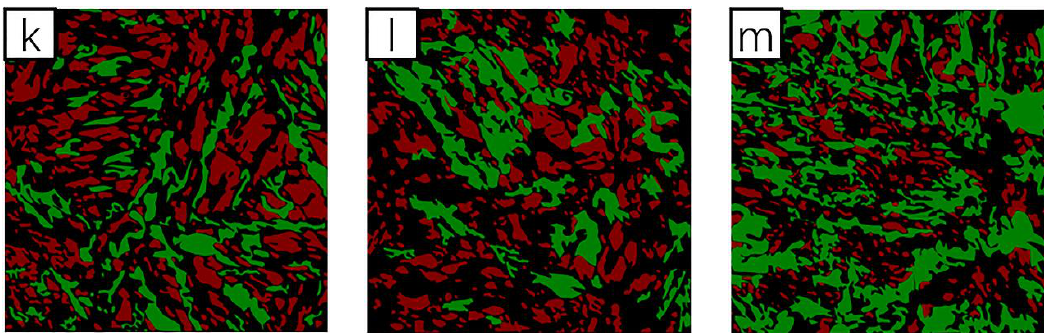
Figure 7. The segmentation effect of SegModel-MOS: Acicular martensite (black), retained austenite (red), and lath martensite (green). ( a – f ), the images range from the surface of the carburized layer to the core; ( h – m ), SegModel-MOS model segmentation picture.